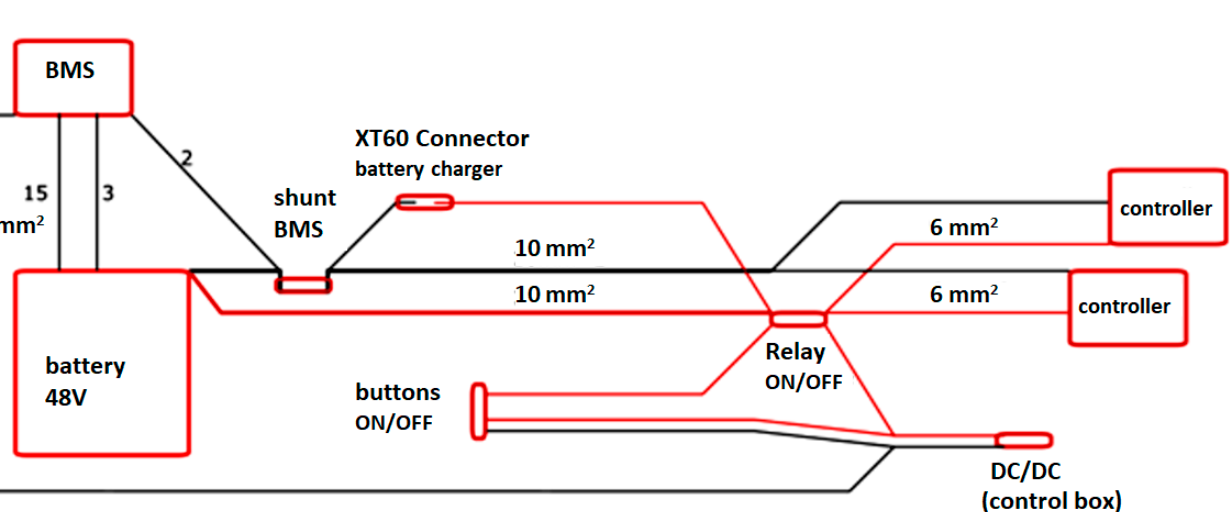
Figure 9. ( a ) Video camera; ( b ) 10.1 ″ IPS 1024*600 resolution screen.